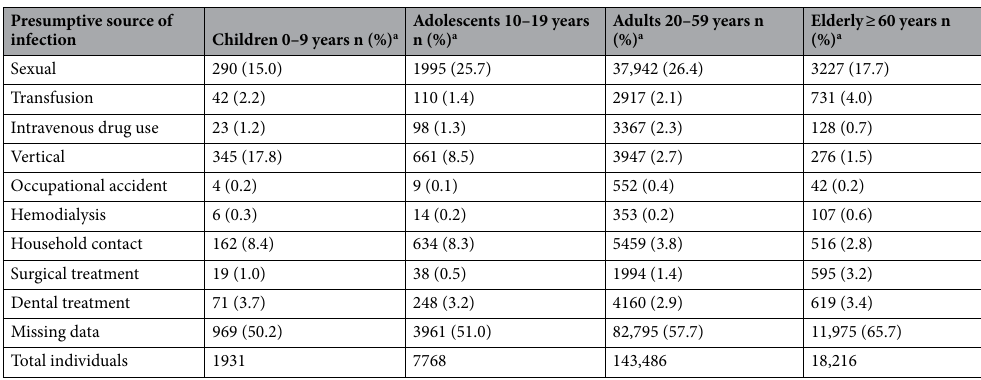
Table 2. Proportion of presumptive sources of infection for Hepatitis B virus according to age in individuals from Brazil during 2007–2018. a The percent values are represented by column.